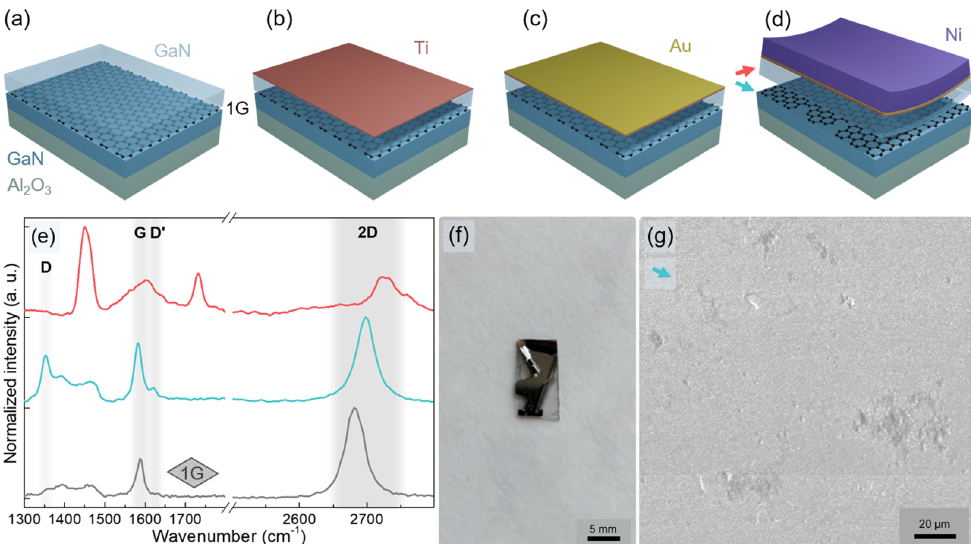
Figure 7. Schematic illustration of metal layer deposition for GaN exfoliation ( a–d ). The thickness of layers is exaggerated. Raman spectra of the template before MOVPE of GaN epilayer (grey line, e ) and after lift-off of GaN–metal stressor stack (blue line, e ). Colored arrows in ( d ) indicate the corresponding surfaces where Raman spectra were measured. Raman spectrum of the exfoliated GaN membrane (red line, e ) ( f ). A stop-motion image of GaN self-exfoliation just after the Ni deposition ( f ). SEM image of graphene interlayer after the GaN epilayer exfoliation ( g ).